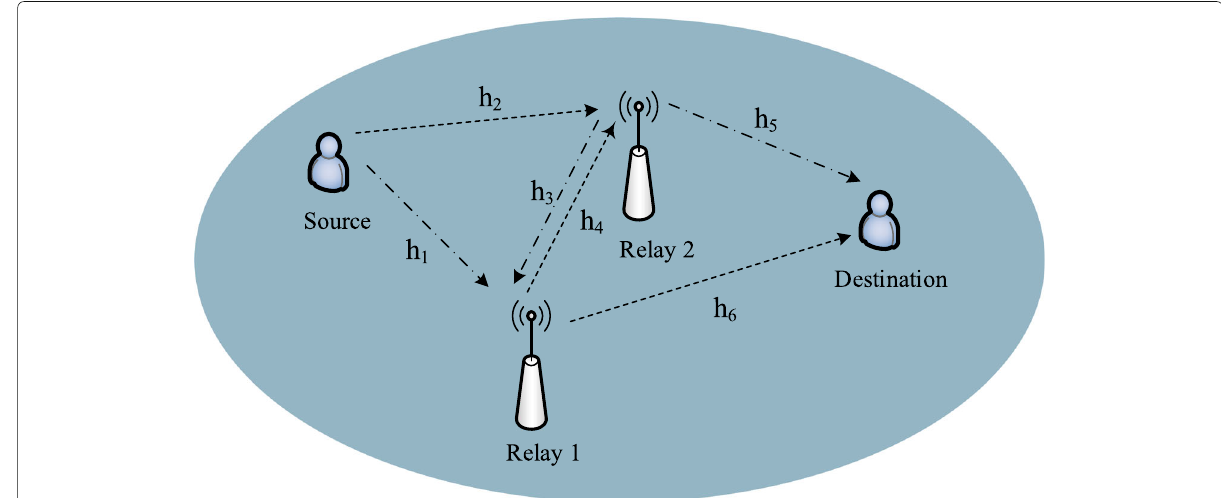
Fig. 1 A sample NOMA-based two-path successive AF relay system